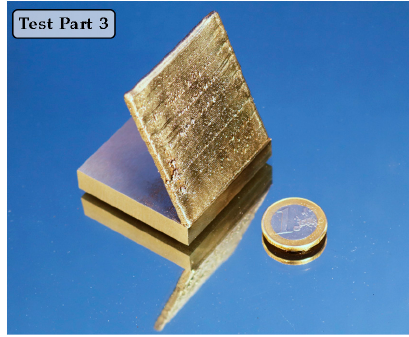
Figure 5. Part manufactured via LMD for Test Part